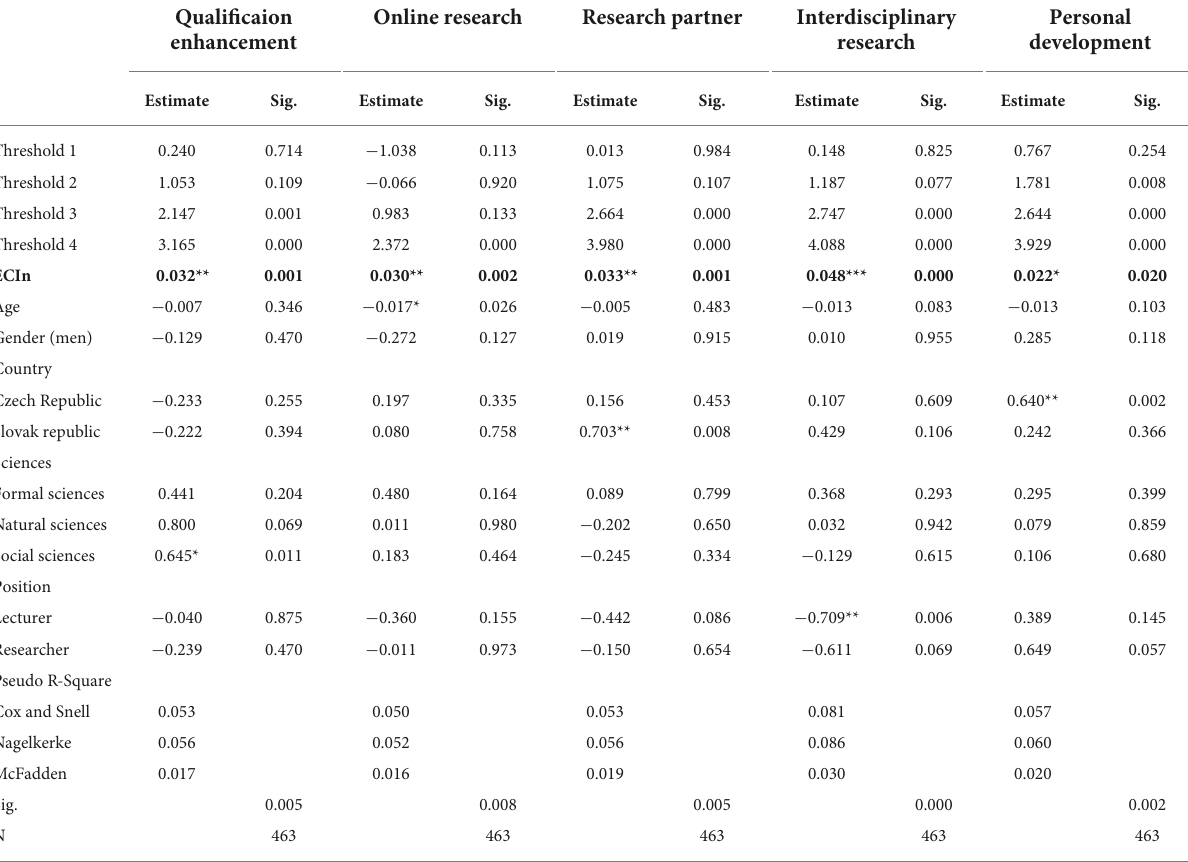
TABLE 5 The novelty component of emotional creativity (ECIn) predicts motivation for innovative research as a response to online teaching during the COVID-19